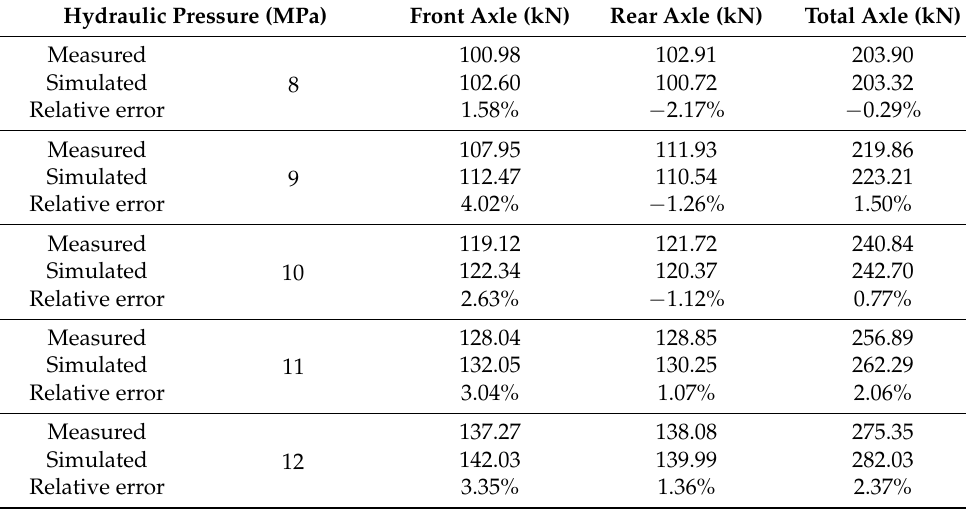
Table 2. Comparison of measured and simulated axle